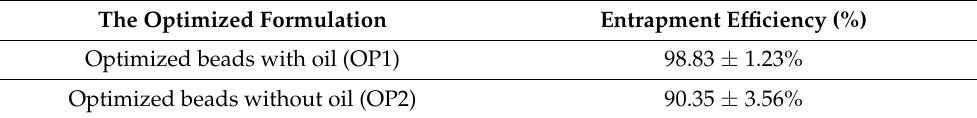
Table 6. The entrapment efficiency of the optimized formulation (OP1 and OP2).